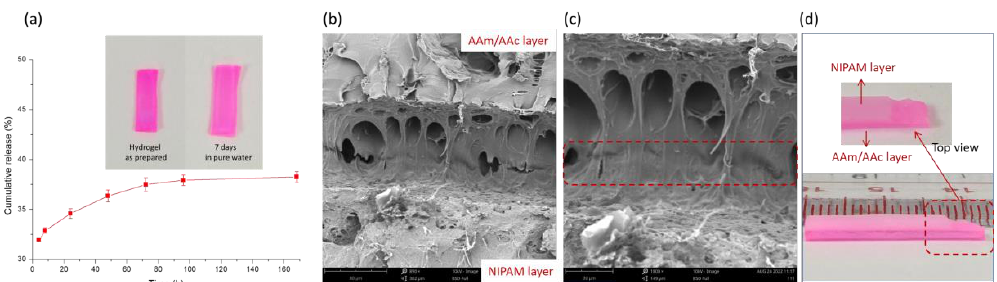
Figure 3. ( a ) Cumulative release of Rhodamine B from AAc/AAm hydrogel ( n = 3), ( b ) low-magnification and ( c ) high-magnification SEM images; ( d ) photos of the bilayer hydrogels in swollen state.